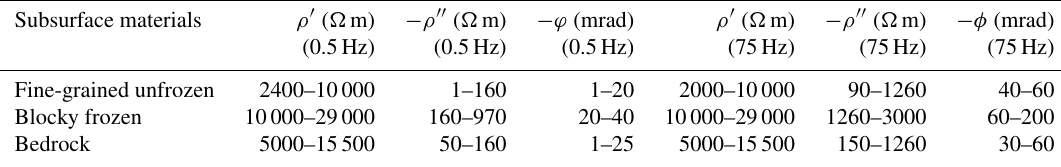
Table 2. Range of complex resistivity values observed in the inversion results of all profiles for different subsurface materials. Subsurface